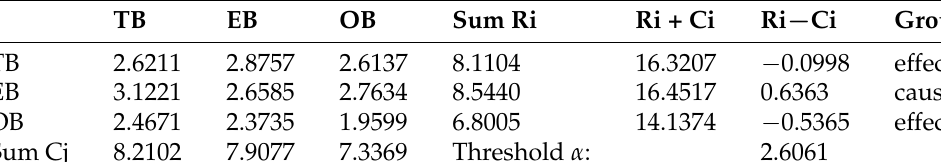
Table 12. Total relation and direct–indirect influence matrix (main barriers).